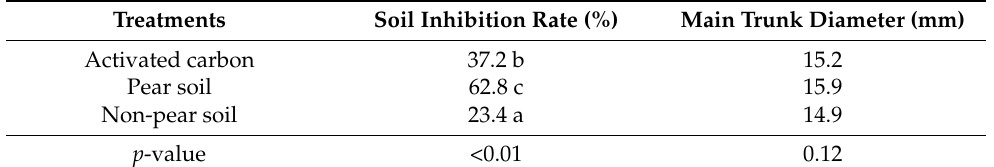
Table 3. Soil inhibition rate at the time of planting and main trunk diameter of Japanese pear saplings.